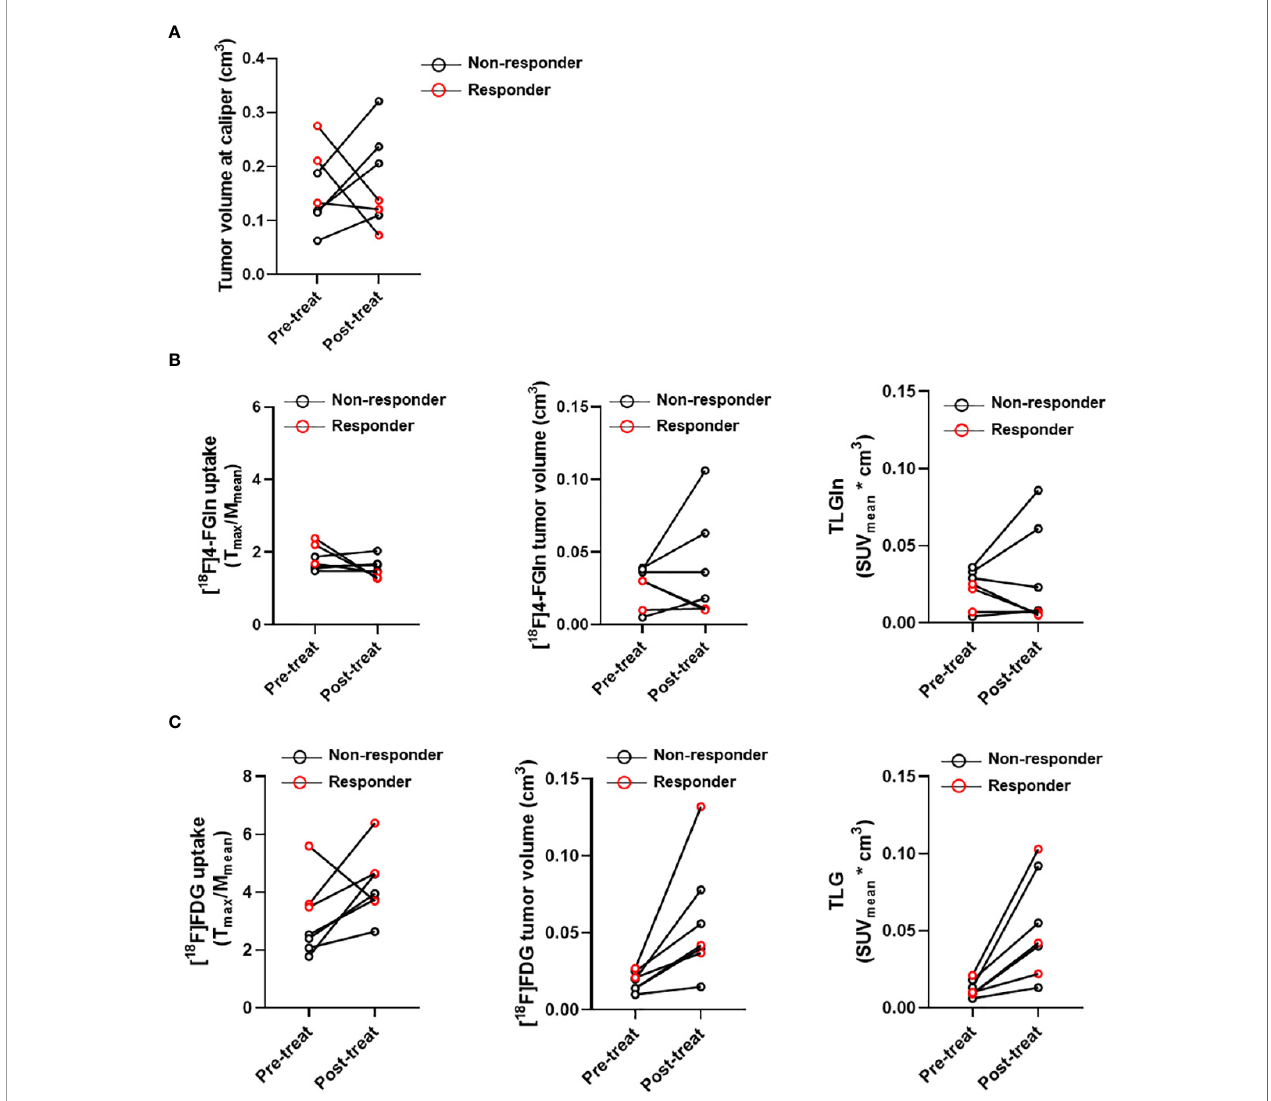
FIGURE 6 | Case by case analysis of “ responders ” and “ non-responders. ” (A) Tumor volume measured at caliper, (B) T/M ratios and tumor volume relative to [ 18 F] 4-FGln uptake and TLGln, and (C) T/M ratios and tumor volume relative to [ 18 F]FDG uptake and TLG pre- and post-treatment with Bortezomib in responder (red circles) and non-responder cases (black